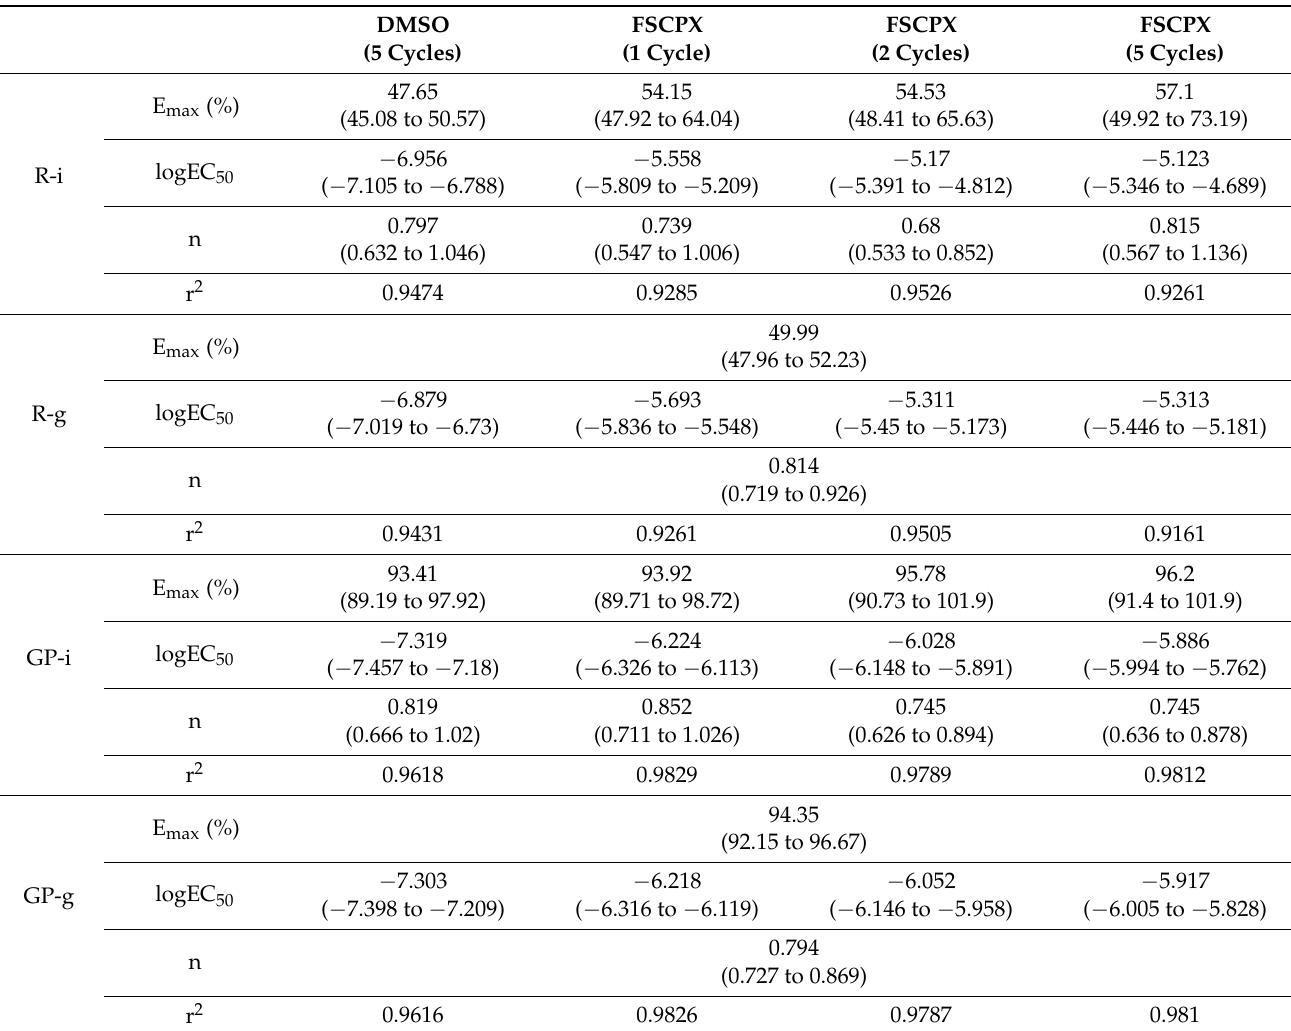
Table 2. Parameters (and their 95% confidence limits) of the Hill model (Equation (1)) fitted individually and globally to the averaged CPA ( N 6 -cyclopentyladenosine) concentration–effect (E/c) data of four groups of rat as well as guinea pig left atria (presented in Figure